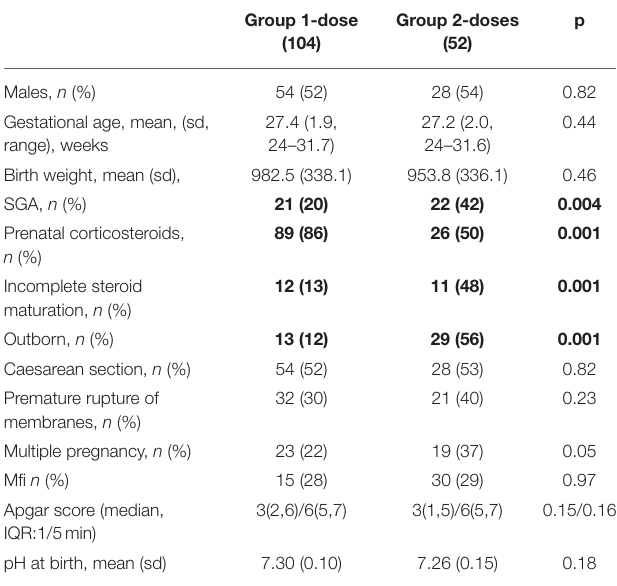
TABLE 1 | Perinatal characteristics of the